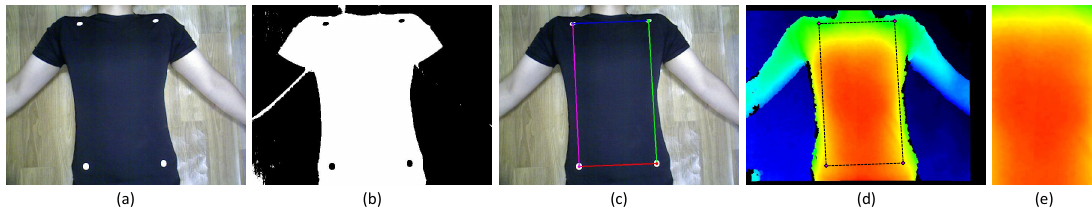
Figure 3. The process of rectangular ROI generation. ( a ) Captured visual image; ( b ) after binarization using Otsu’s method; ( c ) defining the measuring area after finding the center coordinates of the four markers; ( d ) identified measuring area projected onto the aligned depth image; ( e ) generated rectangular ROI using perspective transformation.